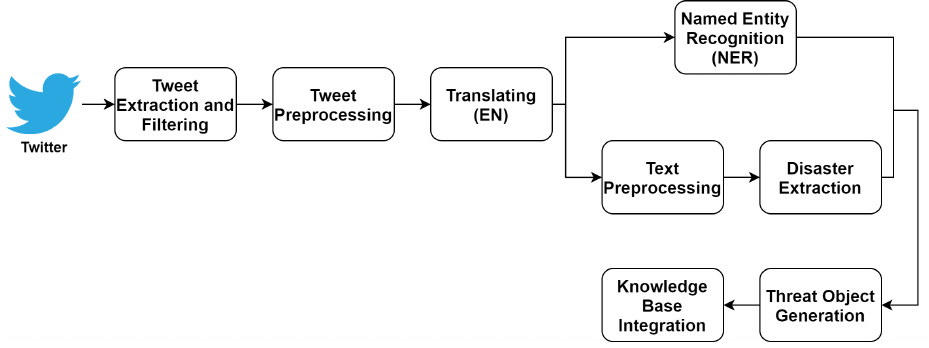
Figure 1. DisKnow’s process